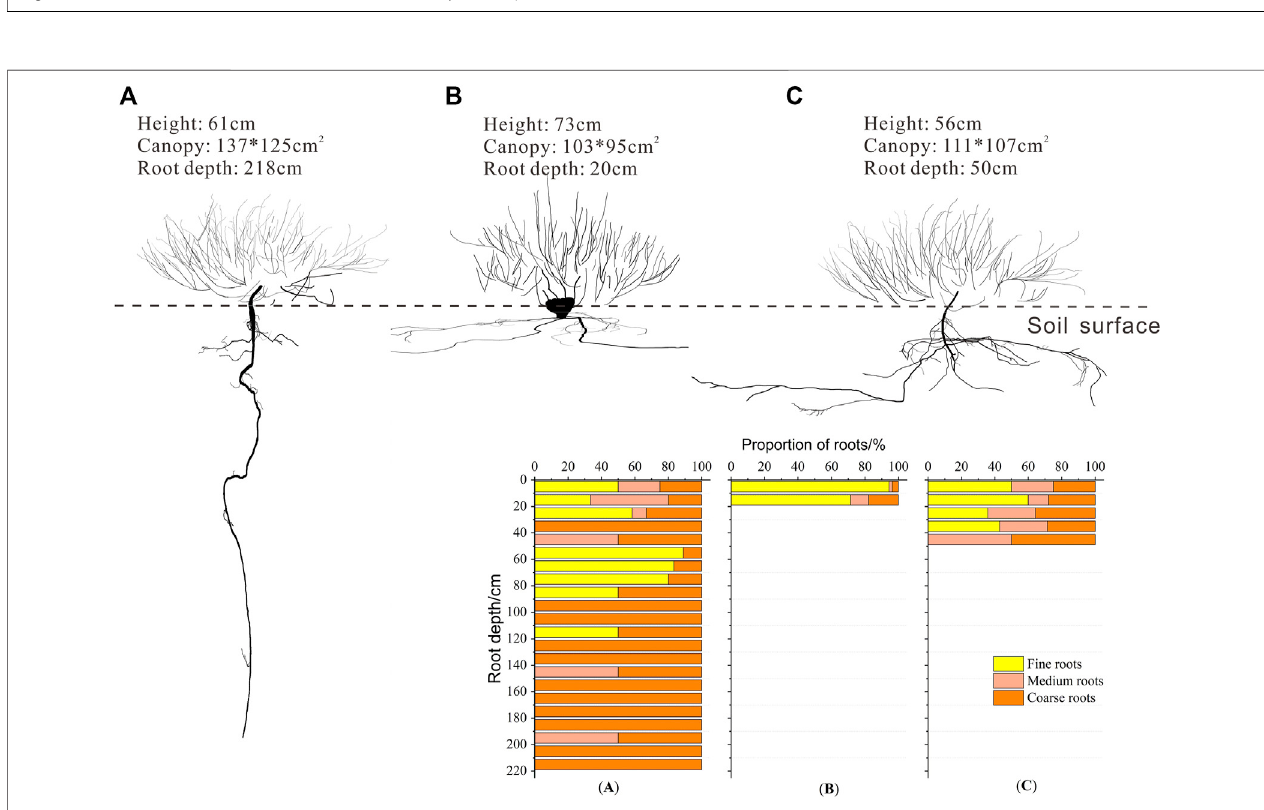
FIGURE 4 | Root distribution of Artemisia ordosica (Ao) in positions with different dune geomorphology. (A) Windward, (B) top of the dune, and (C) leeward.